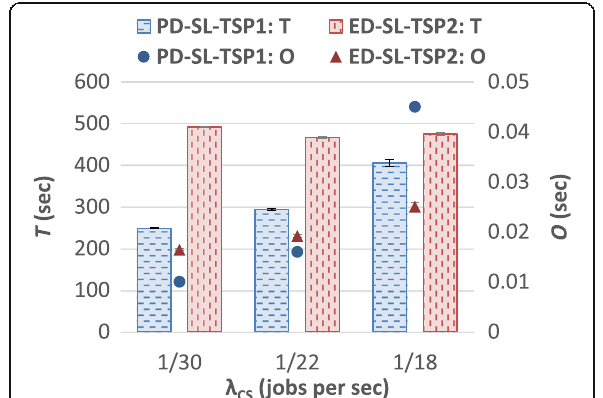
Fig. 7 Effect of λ CS on T and O when using the CyberShake workload